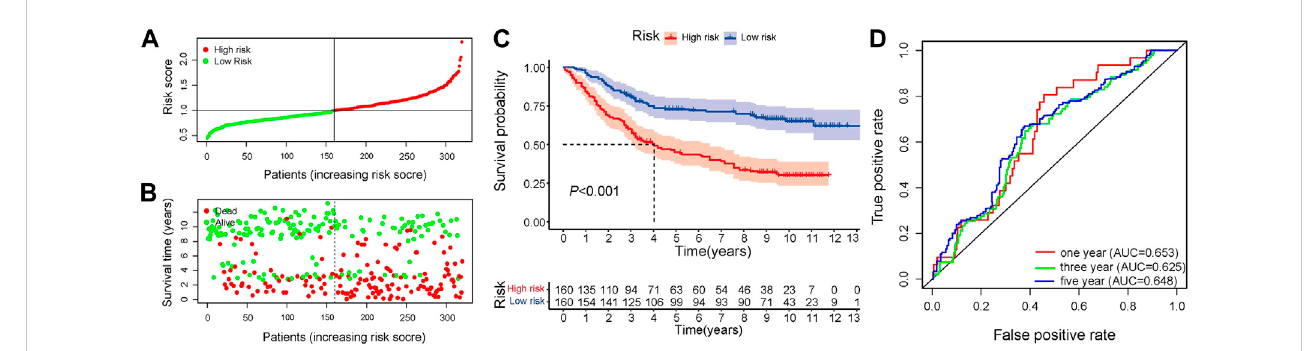
FIGURE 5 Analysis of clinical independence. (A) Heatmap of the relationship between risk score and clinical factors (* represents p < .05, ** represents p < .01, *** represents p < .001). (B) and (C) Univariate and multivariate cox analysis of risk score and other clinical factors.